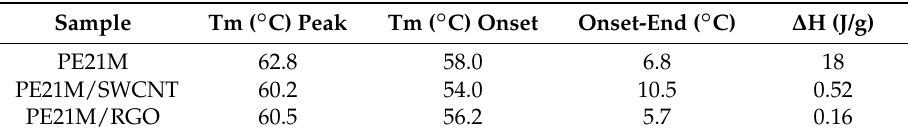
Figure 6. First heating curves of PE21M and PE21M/nanofiller composites in DSC measurement at a constant heating rate of 10 ◦ C/min. ( a ) PE21M/SWCNT nanocomposites, and ( b ) PE21M/RGO nanocomposites. Table 6. Melting data of PE21M and PE21M/nanofiller